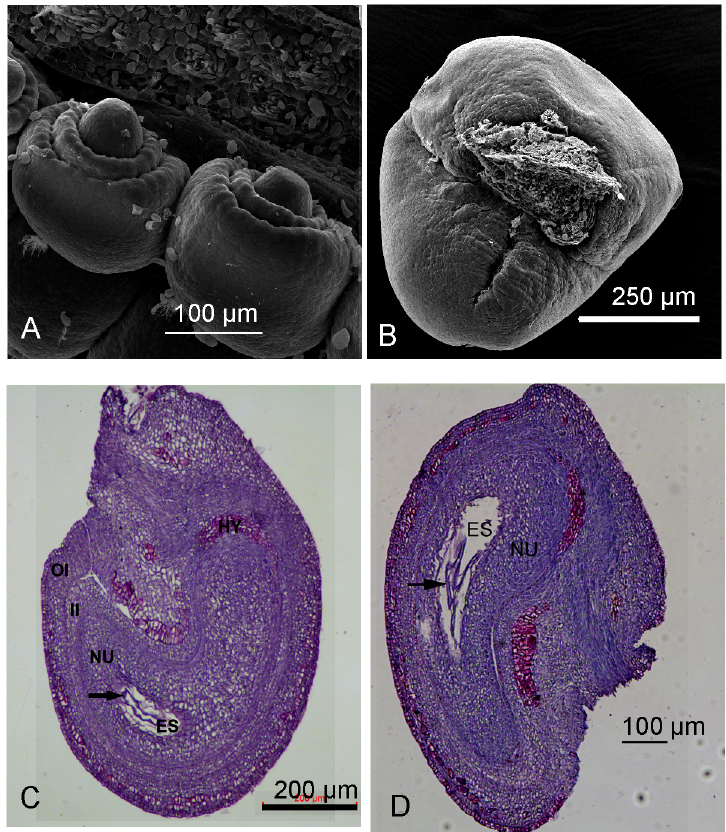
Fig 1. Developing ovules of Xanthoceras sorbifolium . A, B. Scanning electron microscope images. A: Young ovules from a floral bud. B: A selfed ovule at 5 d after pollination (DAP). C and D: Longitudinal section of crossed and selfed ovules at 5 DAP, respectively. Arrows show free nuclear endosperm. Abbreviations: ES, embryo sac; HY, hypostase; NU, nucellus; OI, outer integument; II, inner